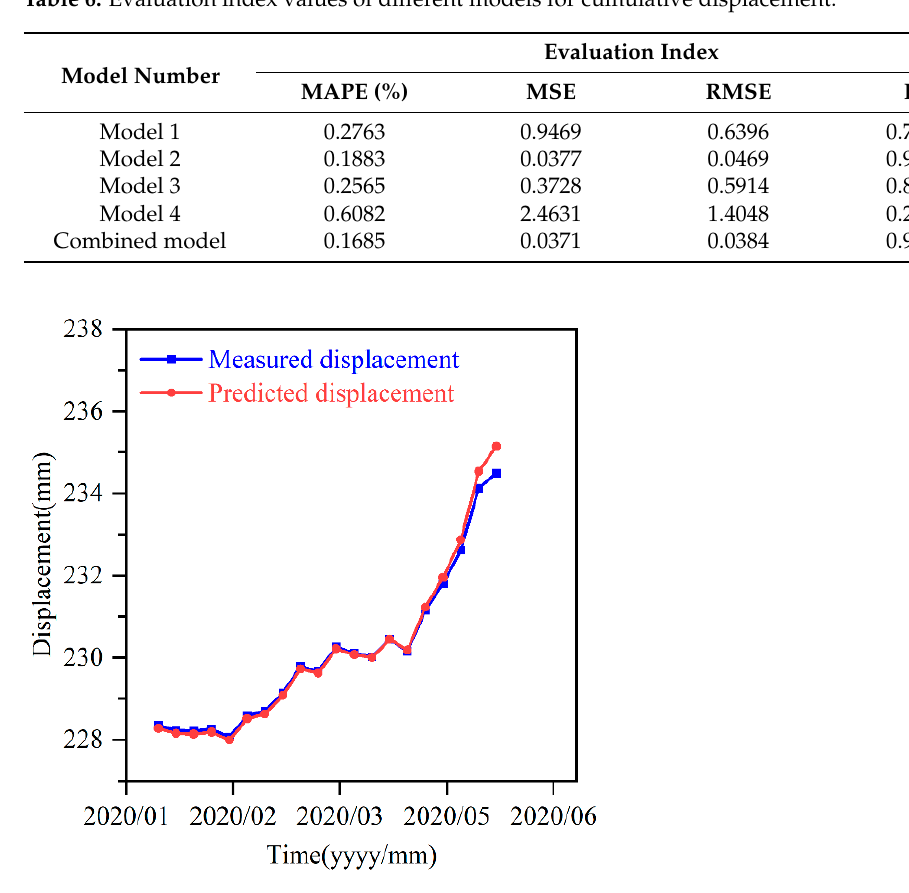
17 of 21 Figure 11. Cumulative displacement prediction results of different training sets: ( a ) prediction re- sults of Model 1; ( b ) prediction results of Model 2; ( c ) prediction results of Model 3; ( d ) prediction